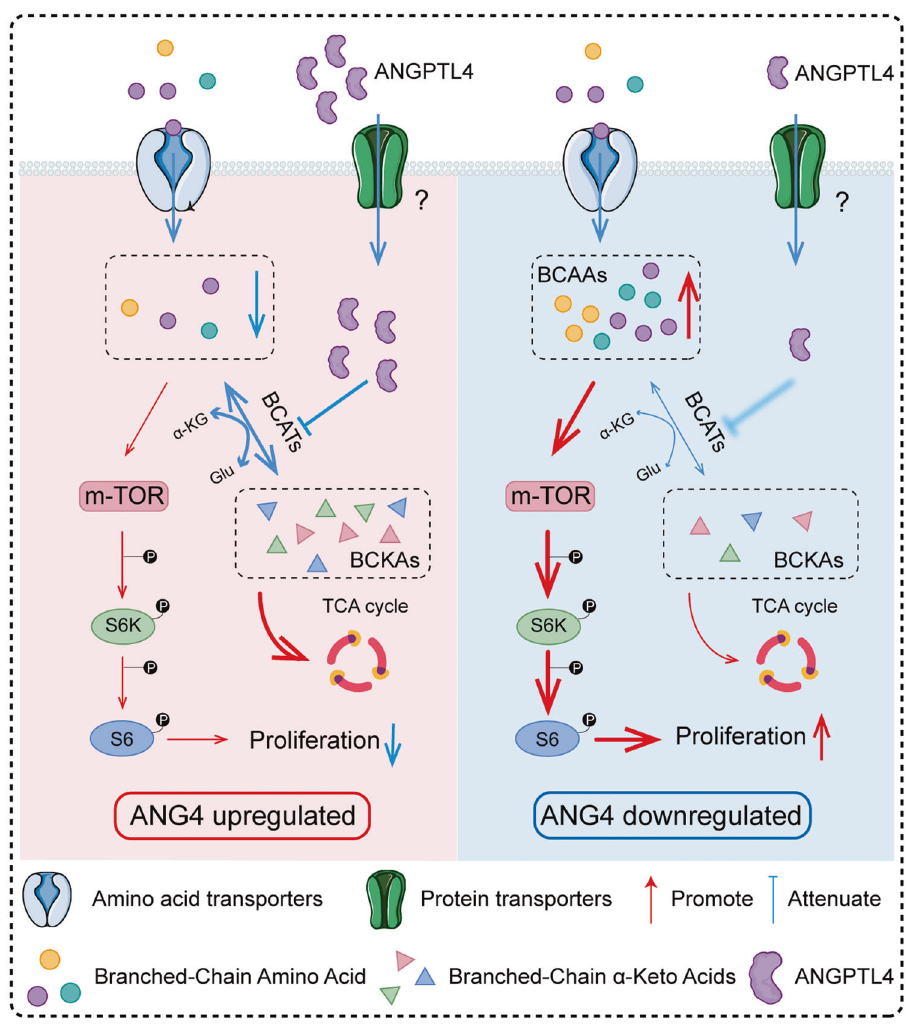
Fig. 8 ANGPTL4 negatively regulates OS cell growth by remodeling BCAA metabolism. Diagram illustrating one mechanism that illustrates how ANGPTL4 in fl uences OS cell progression through the ANGPTL4/BCAAs/mTOR